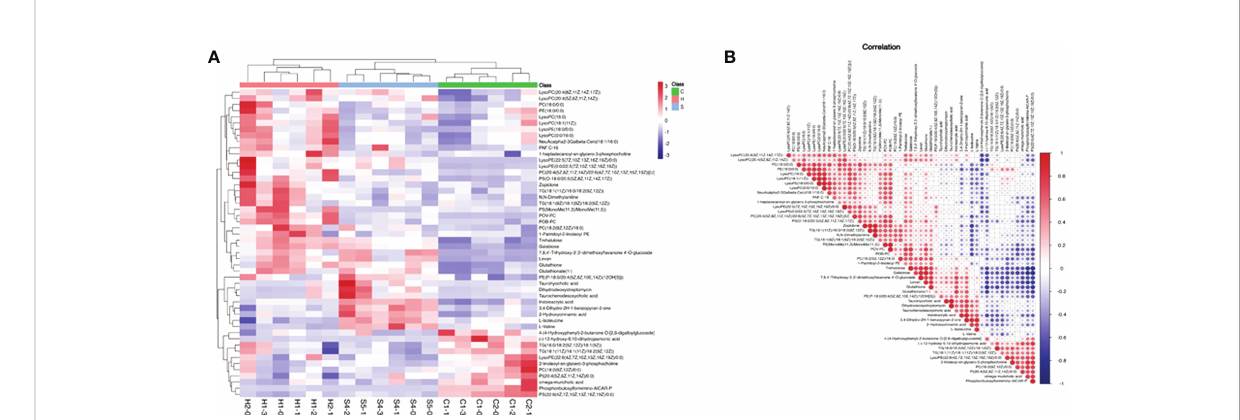
FIGURE 6 (A) Heatmap analysis of differential metabolites with VIP of OPLS-DA greater than 1, and P-value of Student ’ s test less than 0.05; VIP, variable important in projection; OPLS-DA, orthogonal partial least squares discriminant analysis. (B) Heatmap Pearson ’ s correlation analysis was